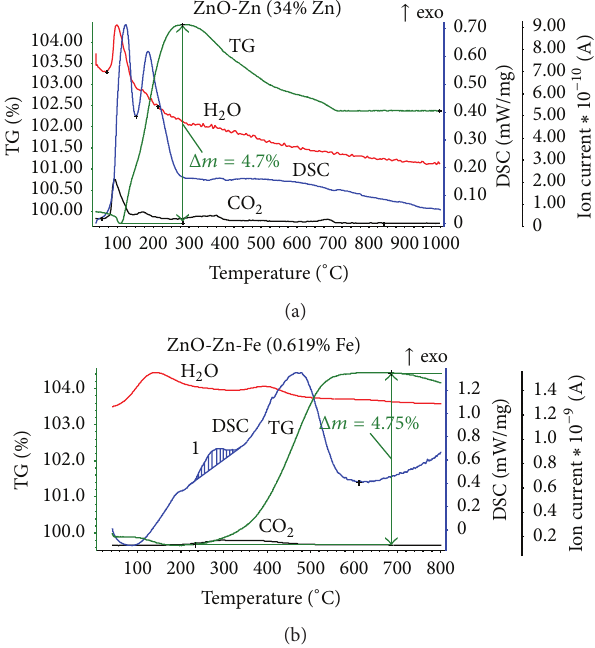
Figure8:HeatingthermogramsDSC-TGandthemassspectraH 2